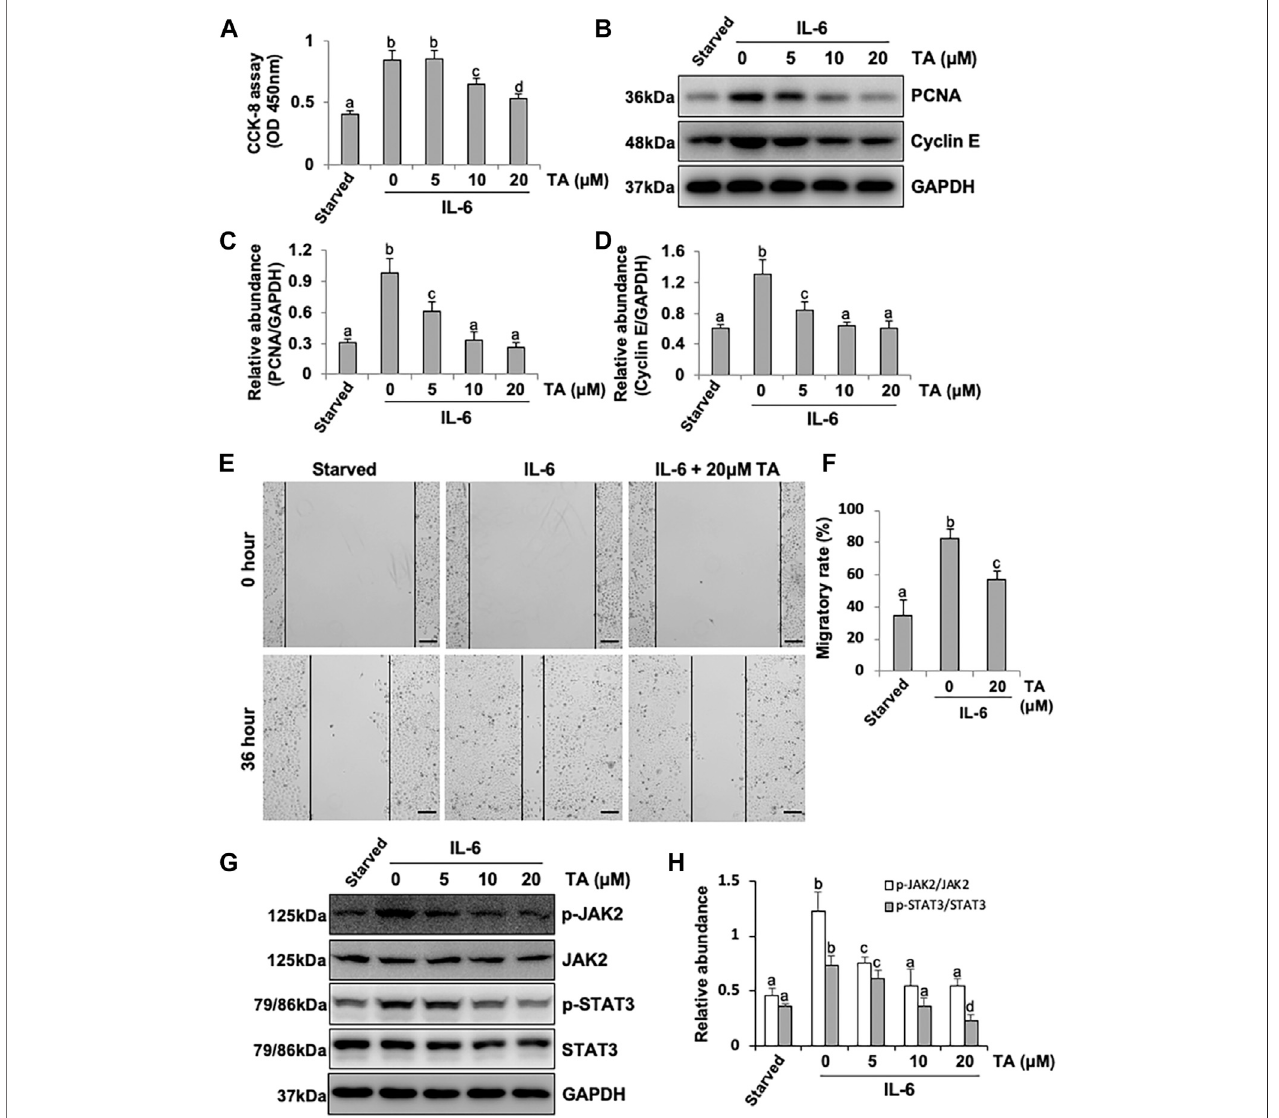
FIGURE6| PharmacologicalblockadeofHDAC6alleviatesproliferationandmigrationthroughtheJAK2/STAT3signalingpathwayinhumanperitonealmesothelial cells. (A) CellproliferationwasassessedbytheCCK-8assay. (B) Celllysatesweresubjectedtotheimmunoblotanalysiswithspeci fi cantibodiesagainstPCNA,CyclinE, and GAPDH. (C) ExpressionlevelofPCNA wasquanti fi edbydensitometryandnormalized withGAPDH. (D) ExpressionlevelofCyclinEwasquanti fi edbydensitometry and normalized with GAPDH. (E) Wound-healing assay of HPMCs treated with IL-6 (100 ng/ml) in the presence or absence of TA (20 μ M). Photomicrographs of migrating cells were taken at 0 and 36 h. (F) The width of the wound was measured, and the migratory rate was calculated. (G) Cell lysates were subjected to the immunoblot analysis with speci fi c antibodies against p-JAK2, JAK2, p-STAT3, STAT3, and GAPDH. (H) Expression levels of p-JAK2 and p-STAT3 were quanti fi ed by densitometry and normalized with JAK2 and STAT3, respectively. Data are represented as the mean ± SEM (n (cid:1) 3). Means with different superscript letters are signi fi cantly different from one another ( p < 0.05). All scale bars (cid:1) 500 μ m.